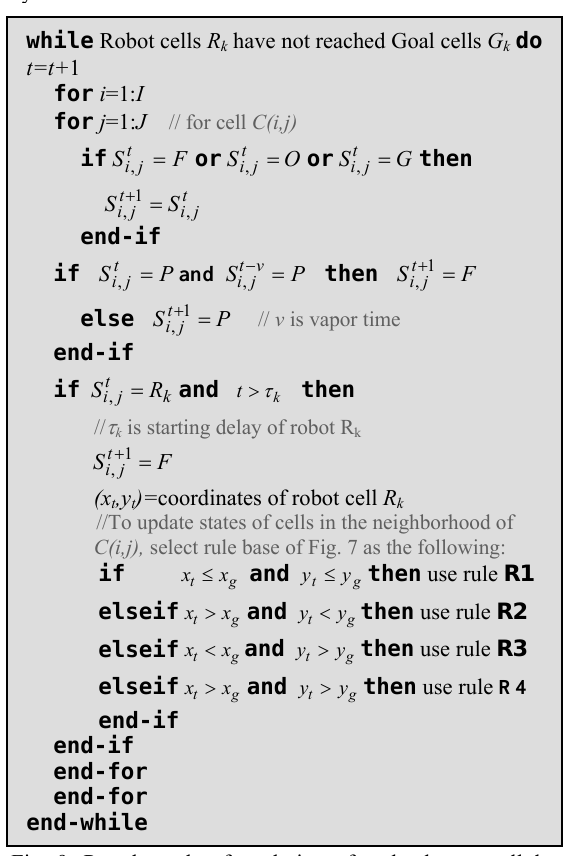
Fig. 9. Pseudo code of evolution of path planner cellular automata modified to be applied for environments with convex and concave